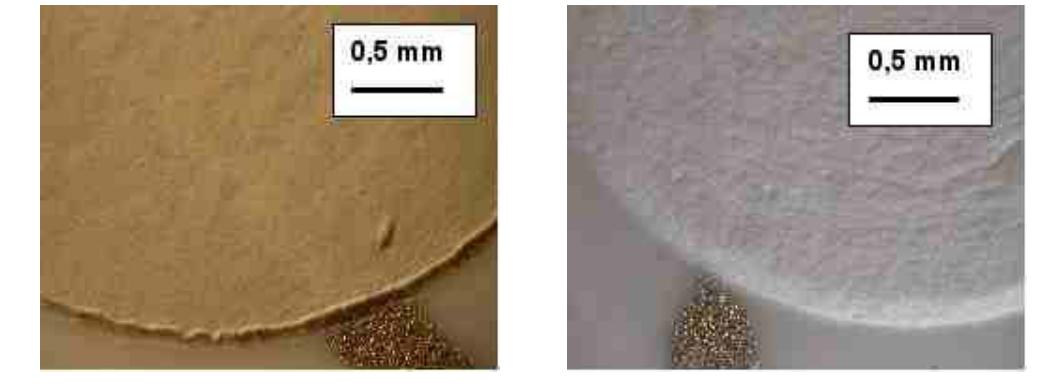
Figure 3. Light optical microscope image of a WO